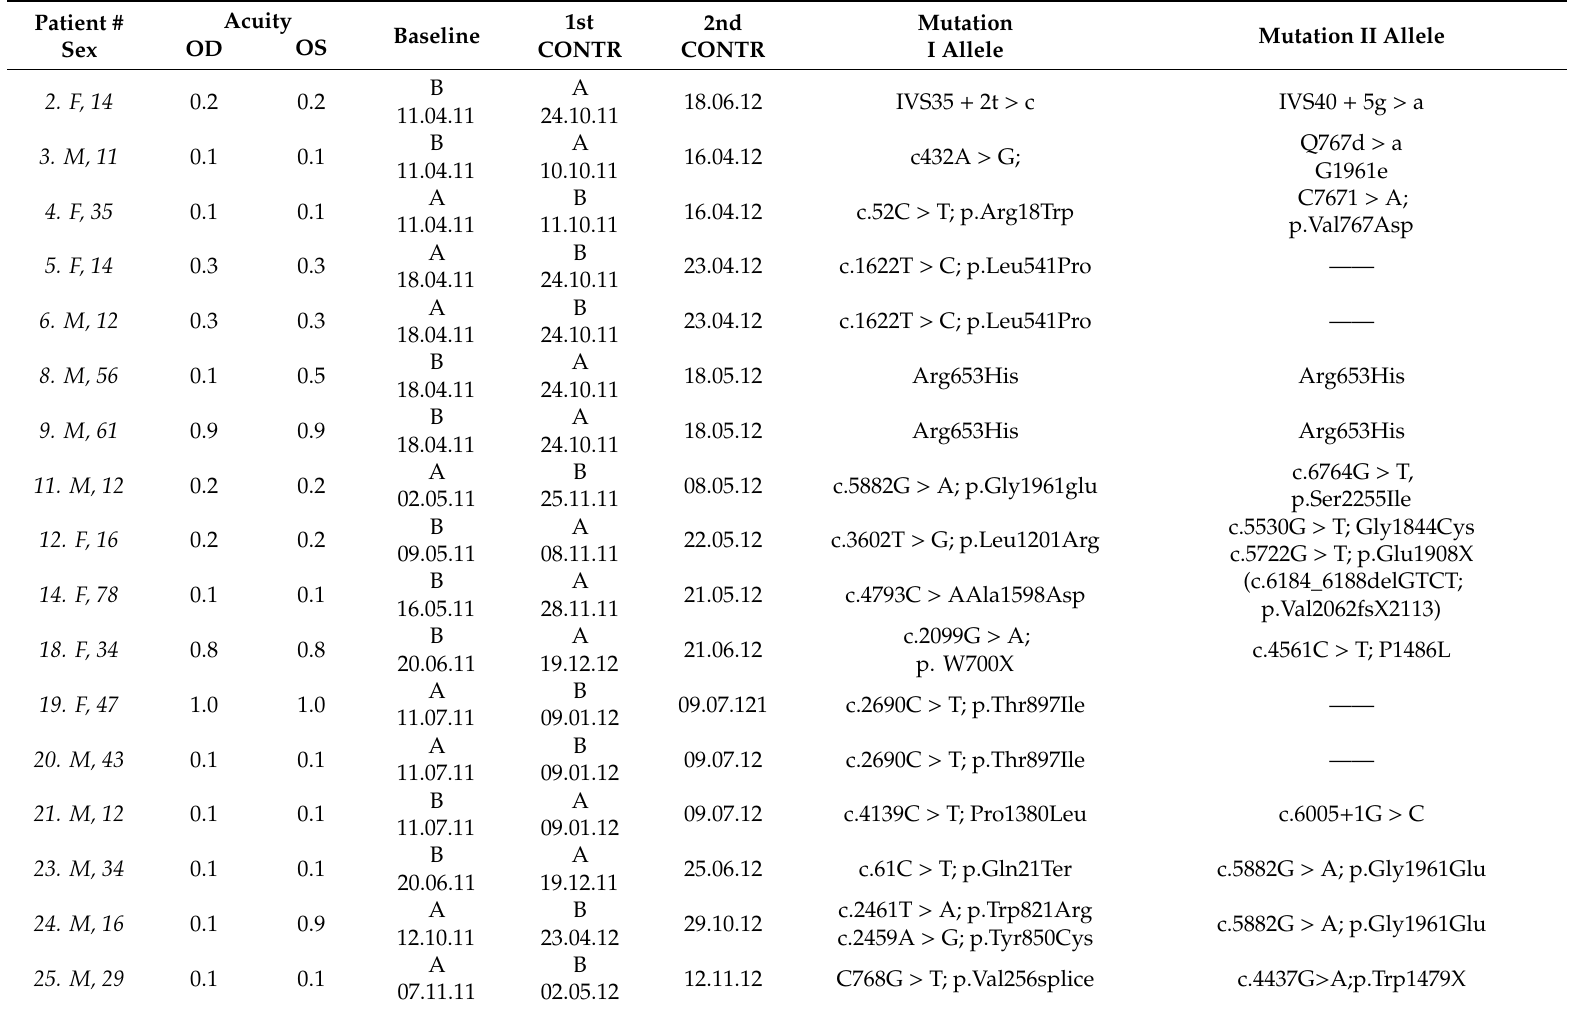
Table 1. Demographic, Clinical and Molecular Data of Patients. Patient ID number